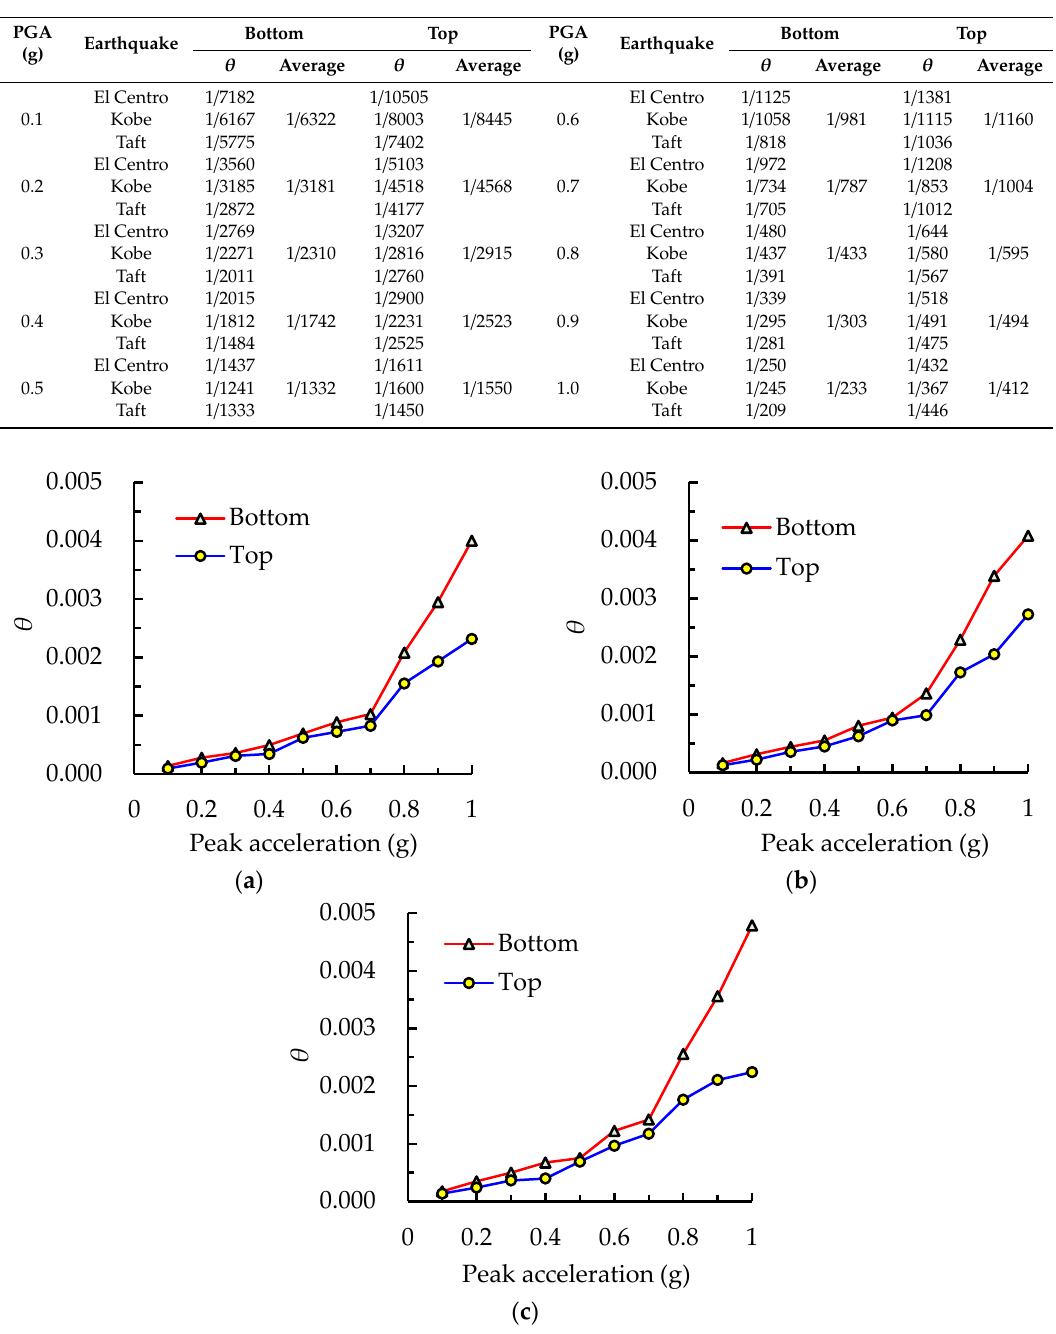
Table 9. Maximum inter-story drift ratios under various intensity levels.